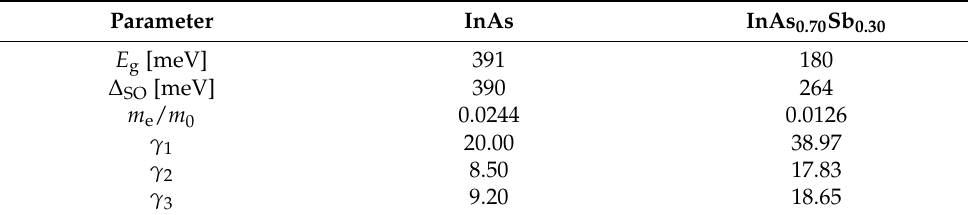
Table 1. Parameters of the binary InAs and ternary InAs 0.70 Sb 0.30 materials at T = 150 K.